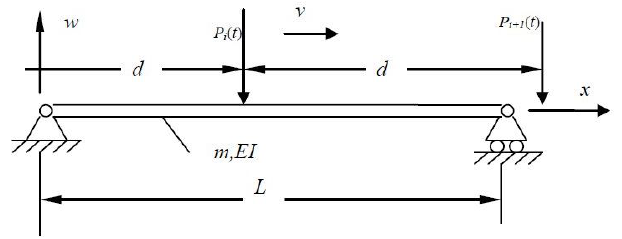
Fig. 1. Simply supported beam with a set of moving loads.